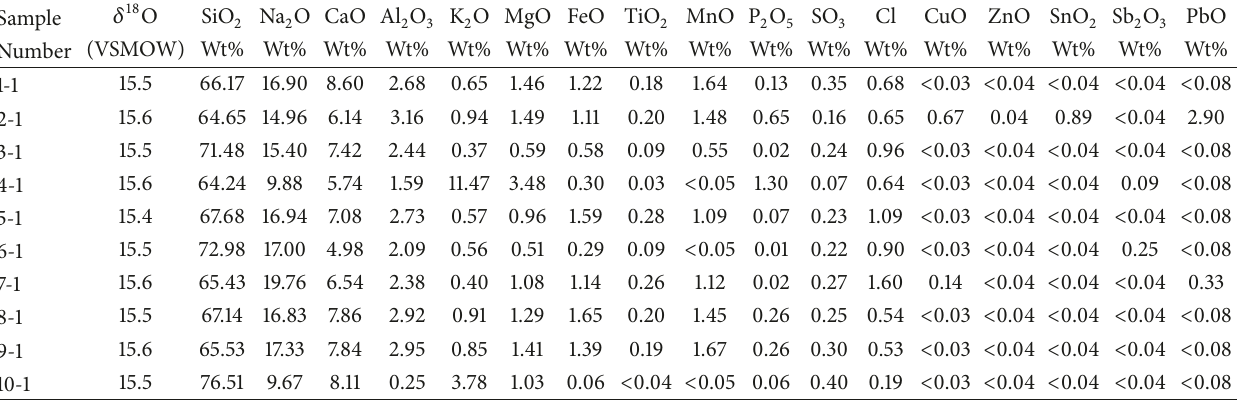
Table 2: Isotopic and chemical composition of Roman and late Antique glasses from Thessaloniki Agora, 1st–6th century AD in age. Note that CoO and NiO contents are not reported because they are lower than EMPA detection limits for all samples (LOD of CoO and NiO = 0.03